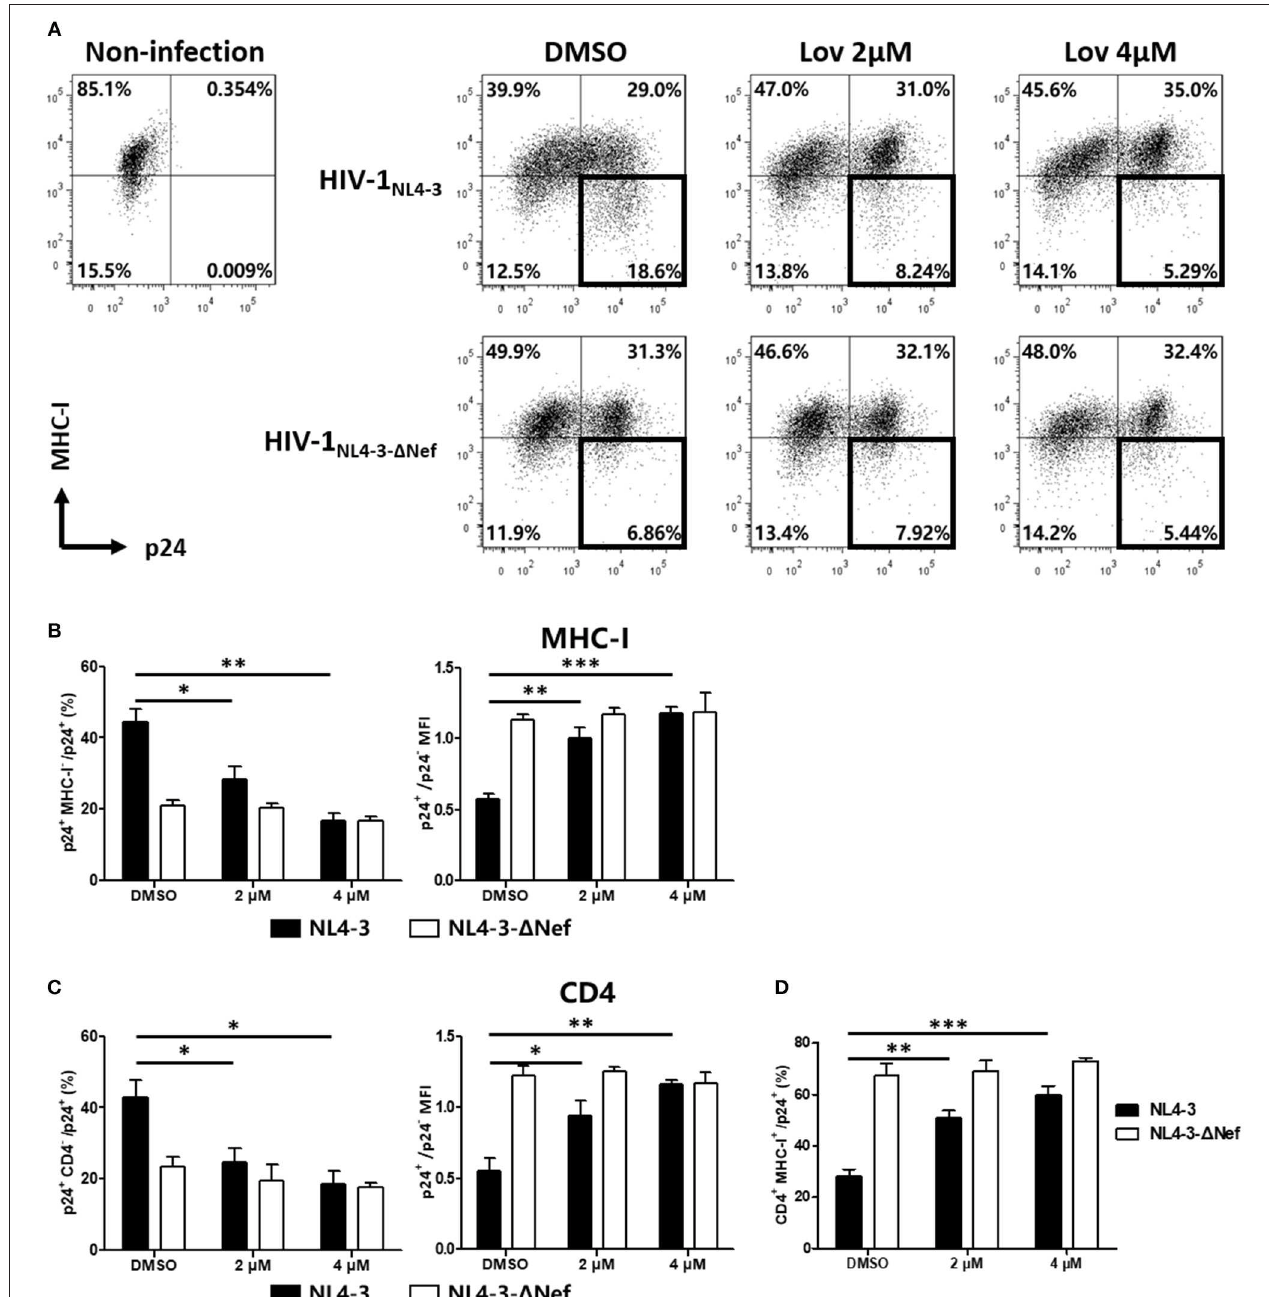
FIGURE 4 | Lovastatin restores the MHC-I and CD4 on cell surface after the HIV-1 NL4 − 3 infection. The activated primary CD4 + T cells were infected with HIV-1 NL4 − 3 or HIV-1 NL4 − 3 1 Nef (p24 titer of 100 ng ml − 1 ). At day 3 post-infection, the cultures were treated with vehicle or lovastatin at 37 ◦ C for 48h. HIV p24 and MHC-I expressions gated on CD3 + CD8 − subpopulation were analyzed by flow cytometry (A) . The percentages of p24 + MHC-I − subpopulation and the ratios of MHC-I MFI on GFP + to GFP − cells from the above flow cytometry analysis were summarized with bar plots (B) . The percentages of p24 + CD4 − subpopulation, the ratios of CD4 MFI on GFP + to GFP − cells (C) , and the percentages MHC-I + CD4 + subpopulation (D) were summarized with bar plots. Data show the means ± standard deviations in three independent experiments. P -values were calculated using the two tailed unpaired Student’s t -test with equal variances, n = 3. * p < 0.05, ** p < 0.01, *** p < 0.001. E63A / F68A × 10 − 3 M). However, the K coupling kit. The SPR sensorgrams confirmed that Nef and D of lovastatin on Nef mutant is about 6.96 × 10 − 4 M, suggesting that these mutations lovastatin bind with a K D of ∼ 1.59 × 10 − 5 M, the binding negatively impact this protein-ligand interaction compared affinity is much stronger than fluvastatin on Nef (K D ∼ 1.123